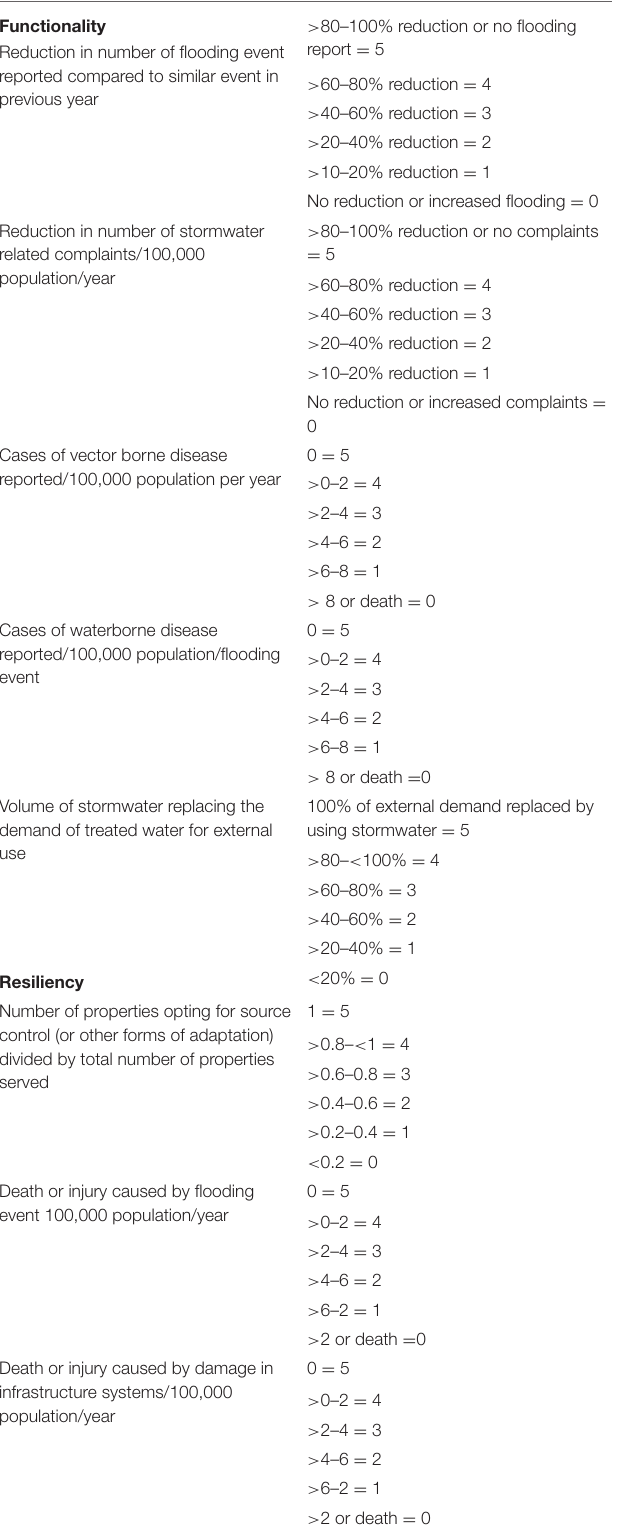
TABLE 2 | Scoring guide for quantitative indicators. Indicators Score assignment